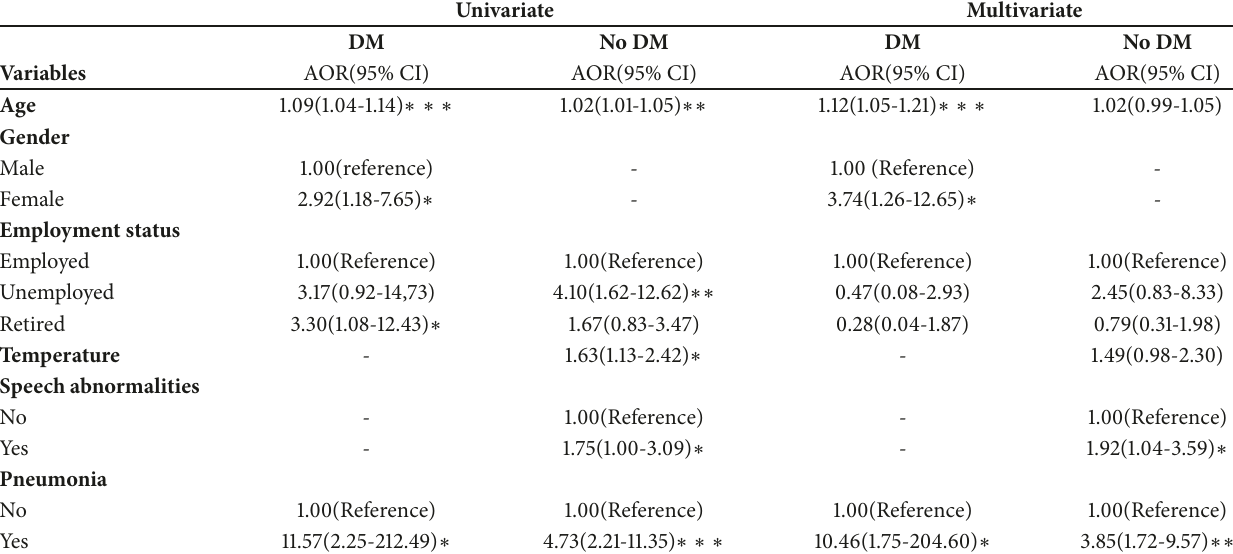
Table 4: Factorsassociated with functional outcome at 3 months for stroke patients with and without diabetes on univariate and multivariate logistic regression